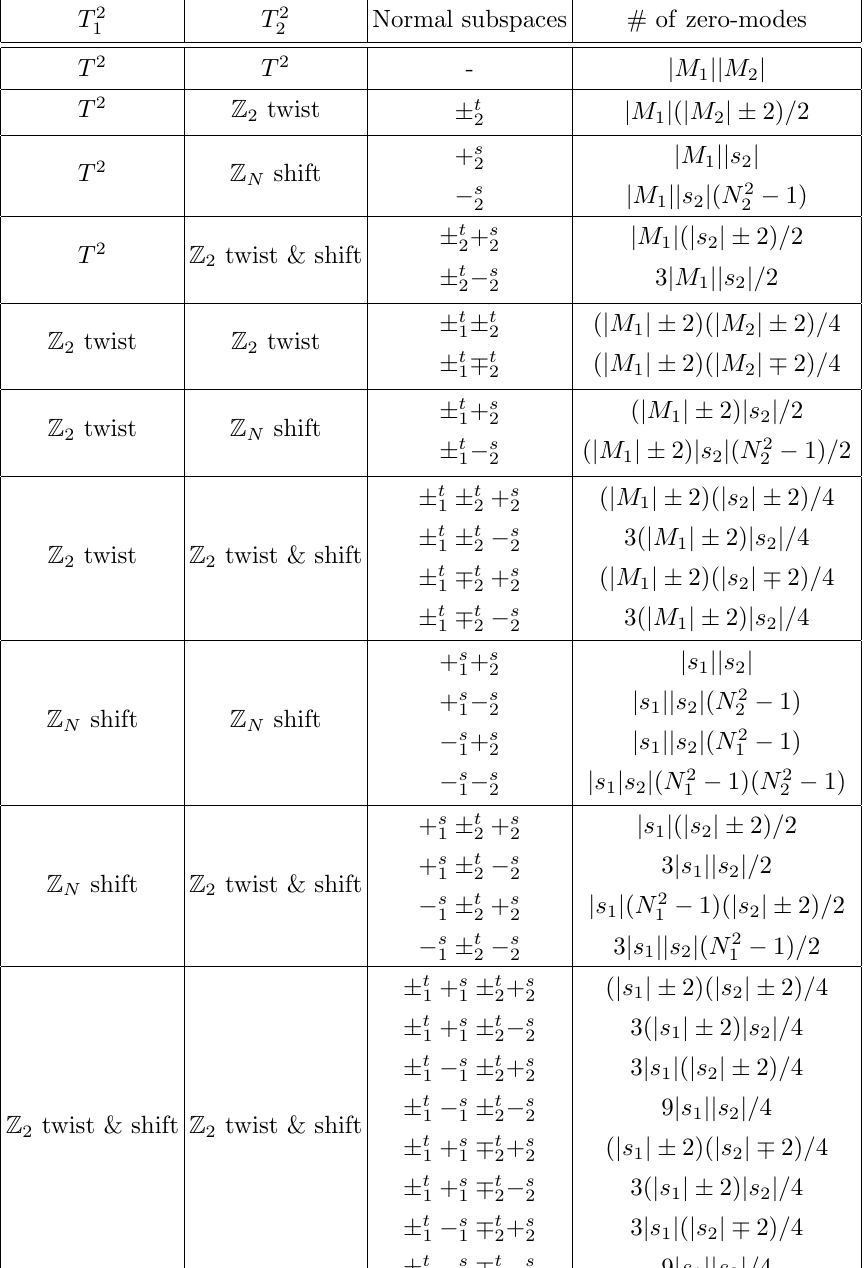
Table 2 . The number of zero-modes on each normal subspace for the ( T 2 shift orbifolds. The (cid:12)rst (second) column shows the types of orbifolds from T 2 include T 2 ( T 2 ) itself. The third column shows the normal subspaces (eigenmodes) labeled by the 1 2 Z t and the Z 2 -twist eigenmodes (cid:6) N -shift eigenmodes (cid:6) with table 1. The last column shows the number of zero-modes on each normal subspace.